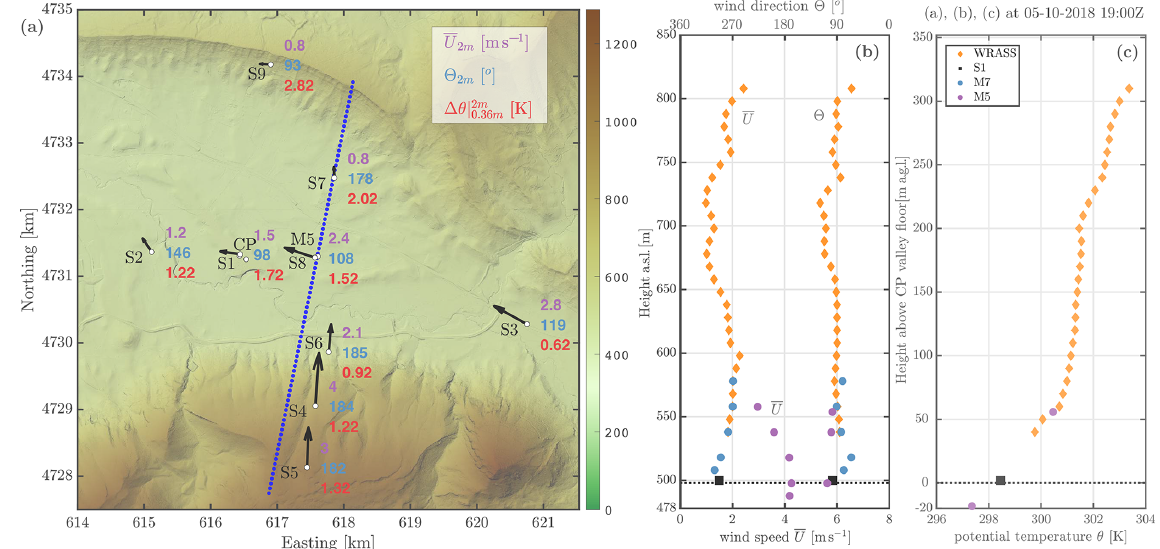
Figure 11. Wind conditions during the hydraulic jump case on 5 October 2018 at 19:00Z. Panel (a) shows surface-layer stations’ wind speed ( U 2m ) and wind direction ( (cid:50) 2m ), both at 2m and potential temperature gradient between 0.36 and 2m ( (cid:49)θ ). Panels (b) and (c) show vertical profiles of wind and potential temperature at the valley from the windRASS, M7, S1 and M5. The dashed line marks the valley floor level at